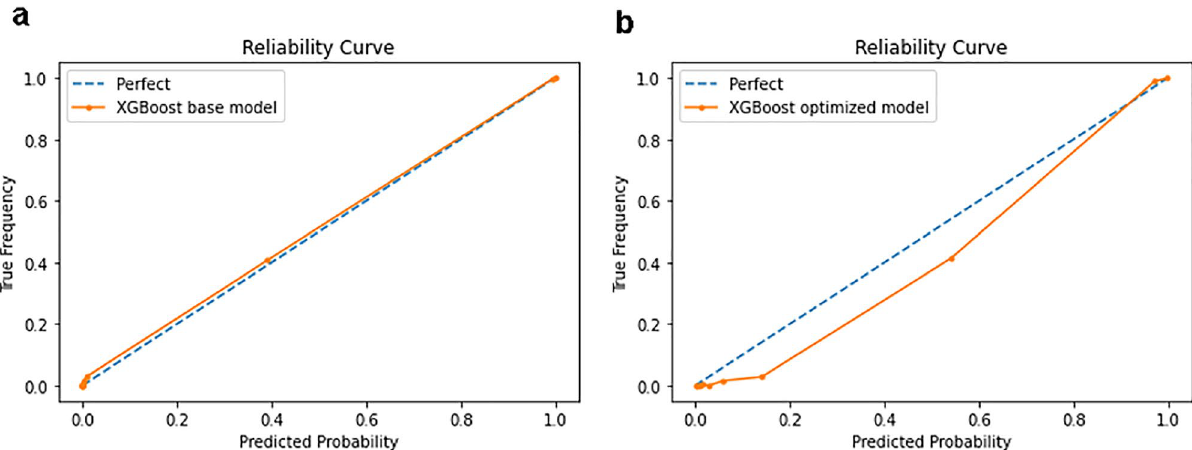
Figure 5. Reliability Curves of XGBoost models for lung cancer risk prediction using 150 K-patient dataset (pt150k). ( a ) Base model with default settings: recall = 0.936. ( b ) Optimized model with optimal hyperparameters: recall =